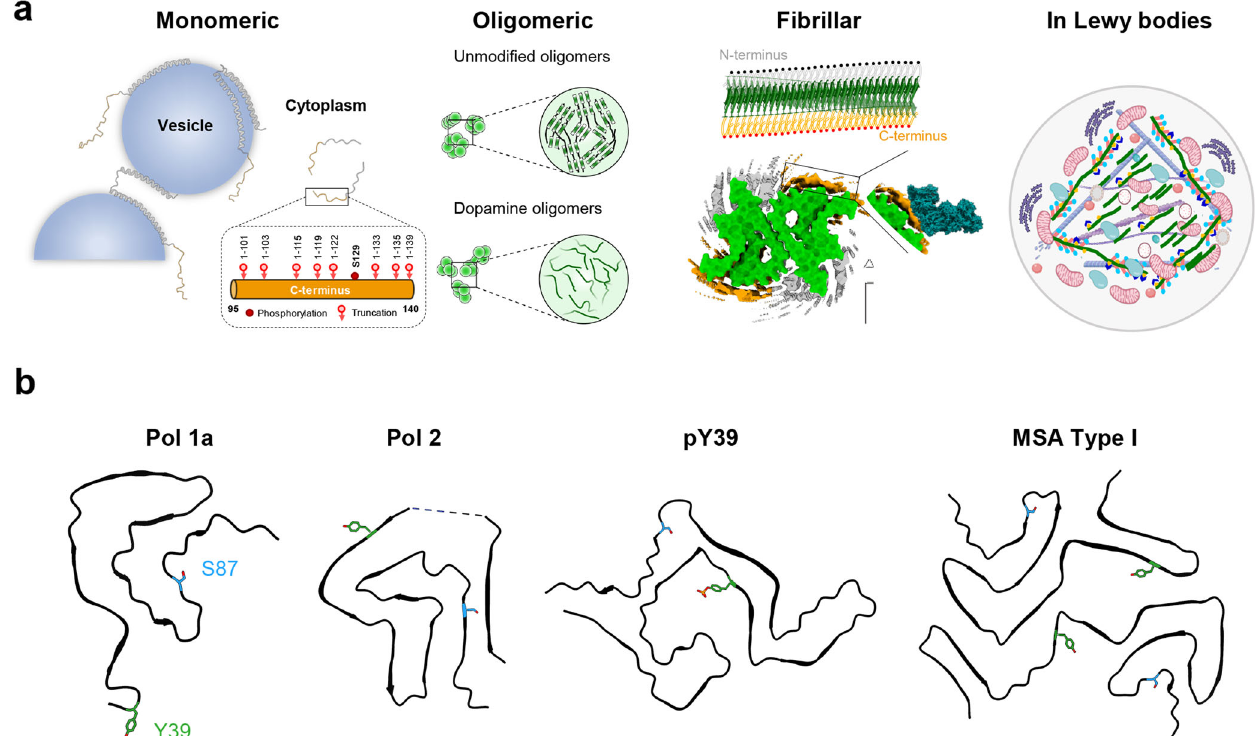
Fig. 10 The multiple faces of aSyn and their susceptibility to post-translational modi fi cations. a The C-terminal domain of aSyn remains disordered and accessible in most aSyn species, from monomers to oligomers, fi brils, and Lewy bodies; monomeric forms of aSyn are predominantly disordered but adopt a-helical rich conformations when bound to vesicles. Despite the absence of an atomic model for aSyn oligomers, several types of aSyn oligomers of distinct conformations (disordered or b-sheet rich) and morphological properties have been observed during aSyn in vitro aggregation 91 . Near-atomic models for aSyn fi bril core structures solved using cryo-EM (depicted model PDB:6CU7, EMDB: EMD-7618) 56 . On top, a schematic depiction of the fi brils showing the amyloid core sequence (green), disordered N-terminus (gray), and disordered C-terminus (orange). In all cases, the protein ’ s C-terminus, which harbors various sites for the protein ’ s truncation and/or phosphorylation, is disordered and accessible. aSyn fi brils found in pathological aggregates are ubiquitinated (black dots), mostly in the N-terminal domain, and phosphorylated, especially at S129 (red dots), and nitrated at multiple tyrosine residues (Y125/Y133/ Y136). In LB, modi fi ed aSyn fi brils represent one of the key components of Lewy bodies and interact with a large number of proteins, membranous structure organelles, and lipids. Many of these interactions are mediated by N- and C-terminal domains that harbor several sites of PTMs. Recent studies demonstrated that these PTMs play key roles in regulating aSyn fi brils remodeling and LB formation and maturation 32,35 . b A selection of aSyn fi brils ’ cryo-EM core structures to illustrate the diversity of aSyn fi bril structures and the positions of other disease-relevant PTM sites (Y39 in green and S87 in blue) present in the fi bril core. One proto fi lament of the in vitro derived fi brils is displayed, including Polymorph 1a (Pol 1a, PDB-6CU7) 56 , Polymorph 2 (Pol 2, PDB-6SST) 101 and fi brils from pY39 monomers (pY39, PDB- 6L1T) 102 . An example of the fi brils derived from the postmortem brain of multiple system atrophy patients is also displayed (MSA Type I,